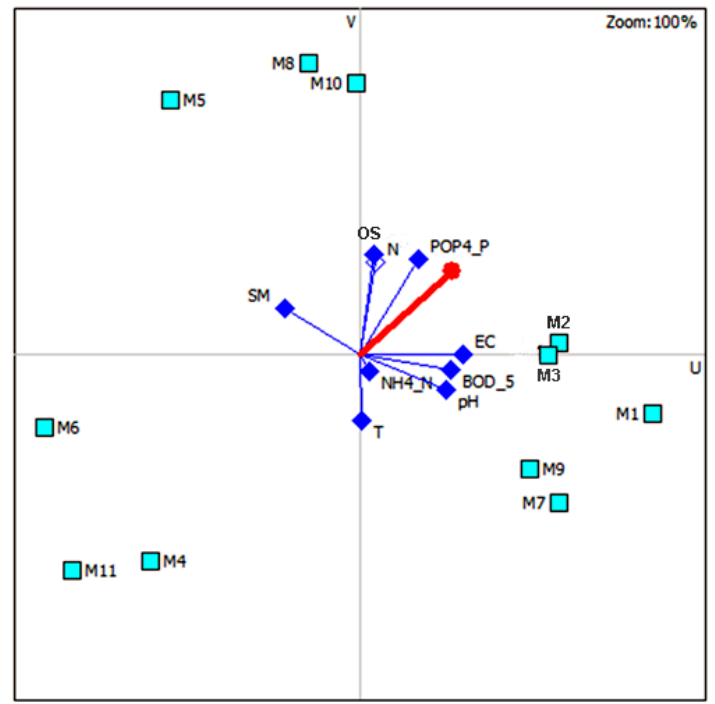
Figure 5. GAIA Figure 5. GAIA plane.